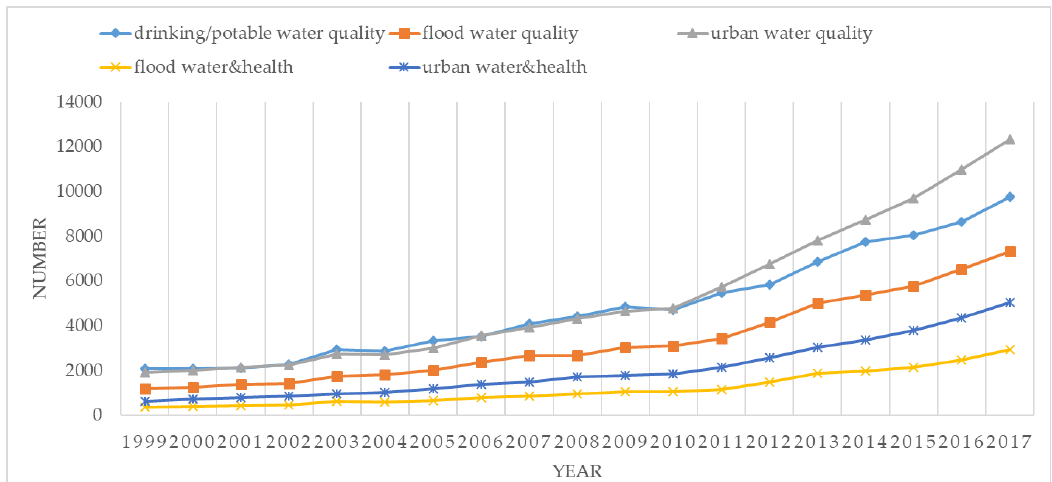
Figure 3. Number of papers published in each year on urban surface water, human health and flooding based on keyword search.